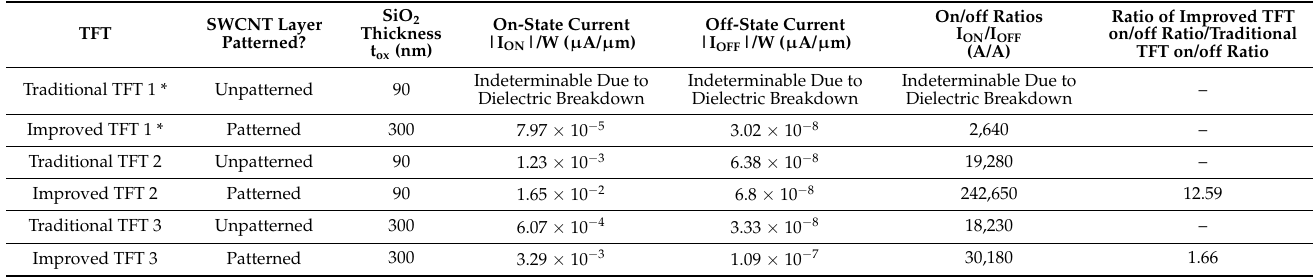
Figure 5. |I D |/W versus V DS characteristics in the triode and saturation regimes of the: ( a ) traditional (unpatterned) TFT with a 90 nm SiO 2 , ( b ) improved (patterned) TFT with a 90 nm SiO 2 , ( c ) traditional (unpatterned) TFT with a 300 nm SiO 2 , and ( d ) improved (patterned) TFT with a 300 nm SiO 2 . Table 2. The on/off ratios of each